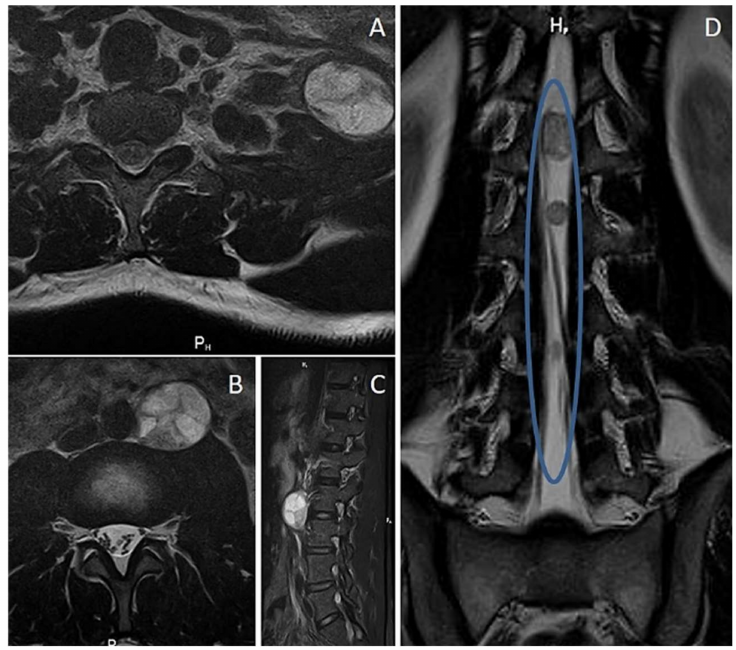
Figure 2. Multiple neurofibromas in an NF1 patient. ( A ) Left laterocervical mass, non-homogeneous, well-defined T2 axial view; ( B ) left lumbar para-aortic mass on T2 axial view and ( C ) STIR sagittal view. ( D ) Intracanalar lumbar tract myelography